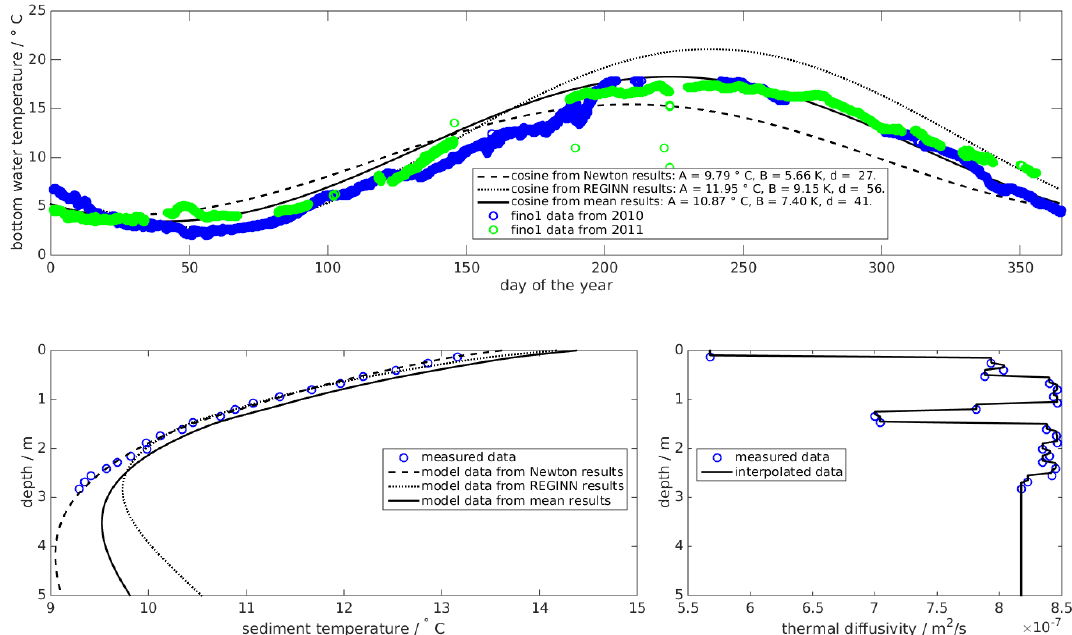
Figure 4. Inversion of the data set near Borkum. In the upper panel, the recorded bottom water temperatures at the BSH station FINO1 are depicted for the years 2010 (green) and 2011 (blue). Additionally, the cosine functions as results of the inversion schemes are plotted: the mean result of the Newton algorithm, the REGINN result, and the overall mean. In the lower panels, the measured temperature (left) and thermal diffusivity (right) are depicted. The resulting temperature–depth profiles from the modeling with the inversion results are plotted together with the measured temperatures in the left panel.